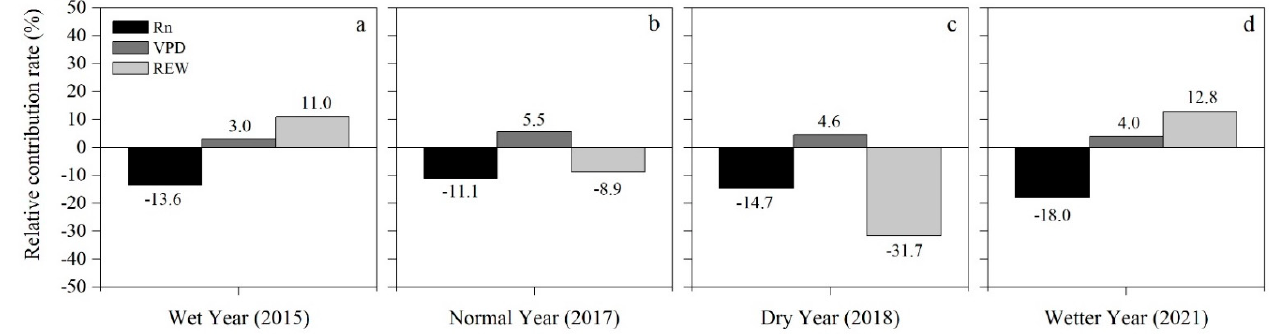
Figure 6. The relative contribution rates of Rn, VPD, and REW to T in the ‘wet’ ( a ), ‘normal’ ( b ), ‘dry’ ( c ), and ‘wetter’ ( d ) years compared to the reference total T. ( c ), and ‘wetter’ ( d ) years compared to the reference total